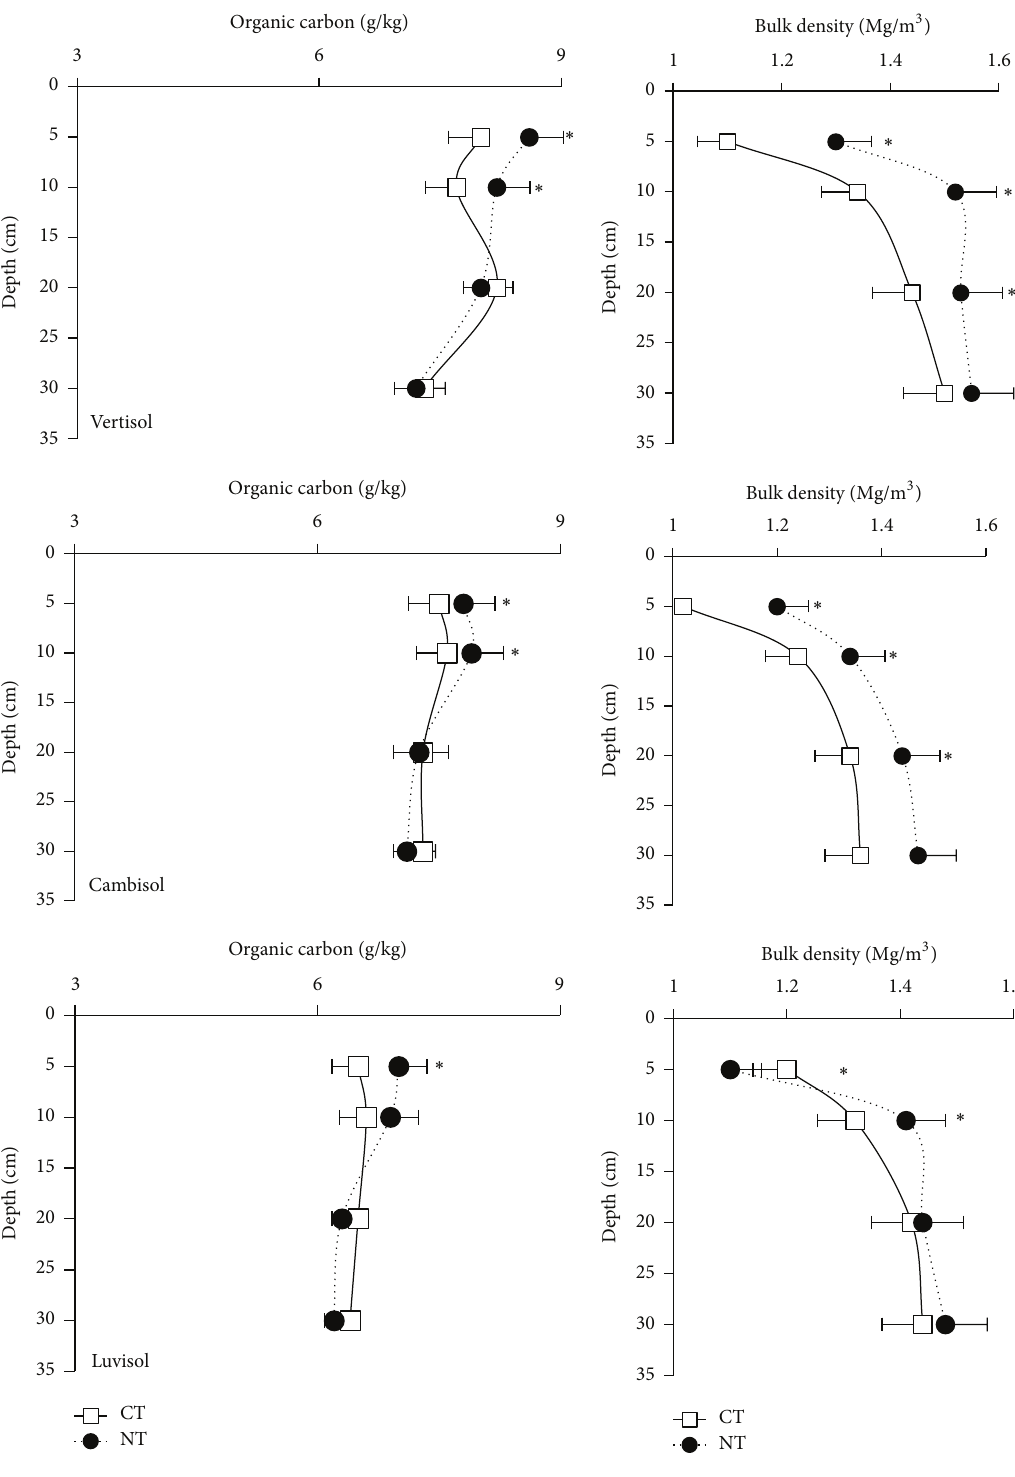
Figure 2: Soil organic carbon content (SOCc) and bulk density ( 𝐷 𝑏 ) in three soil types after 5 years under NT and CT. At each depth, ( ∗ ) means the presence of significant differences between treatments (LSD test, 𝑃 < 0.05 ). The error bar represents one standard